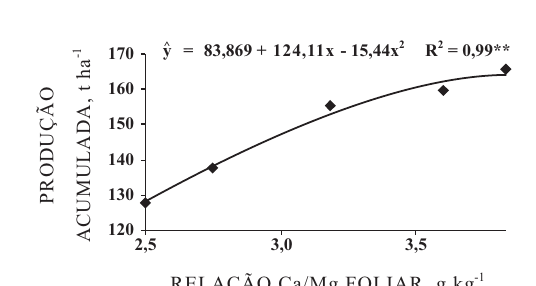
Figura 7. Relação entre Ca/Mg foliar e produção acumulada de frutos das goiabeiras nas safras de 2002 a 2006. Os pontos são médias de quatro repetições em cada ano.